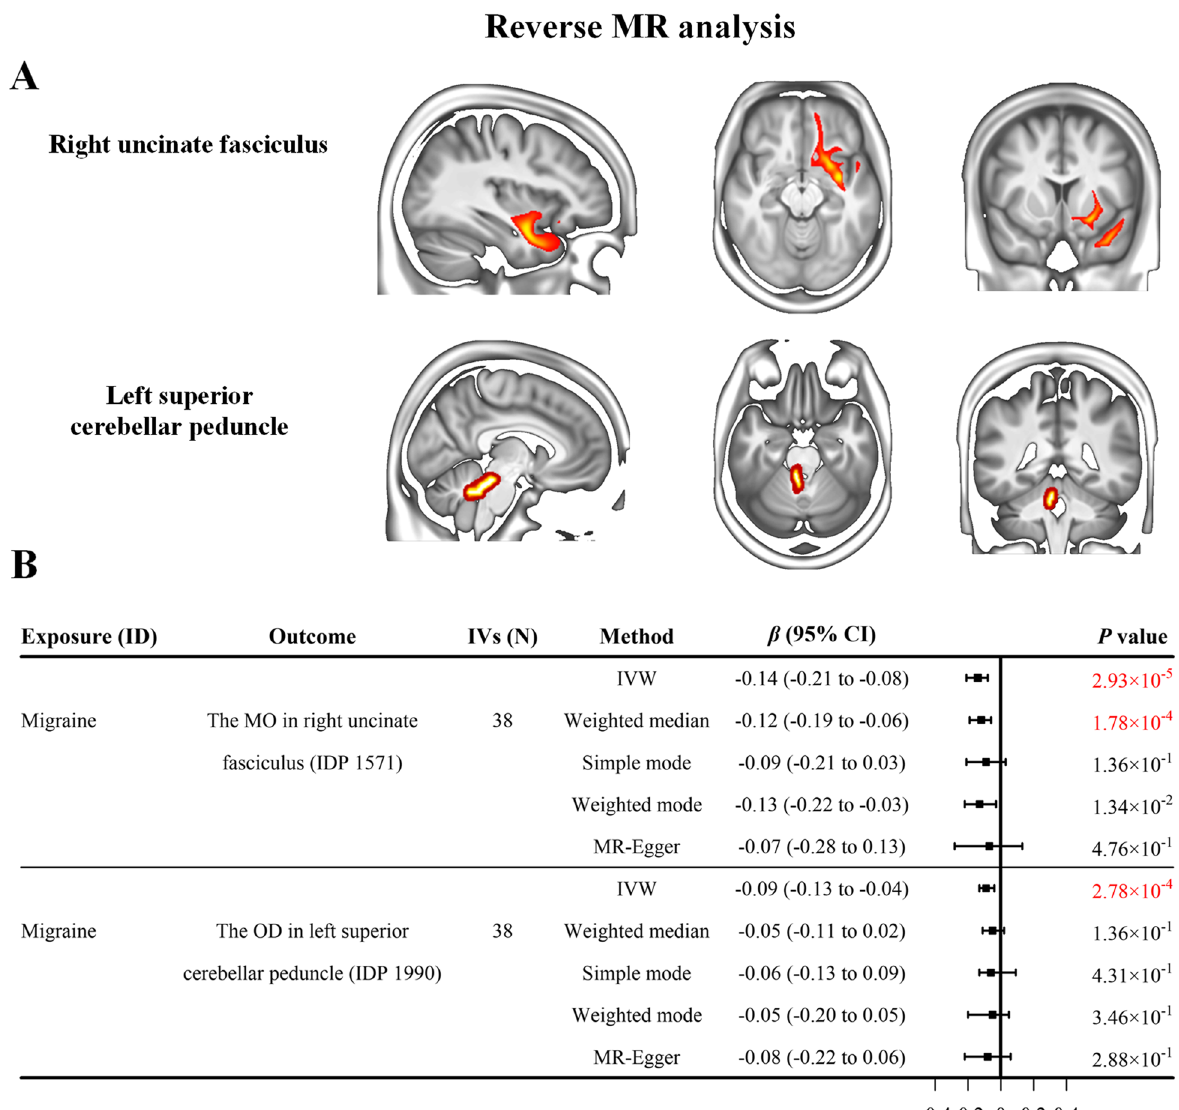
Fig. 3 The results of the reverse MR analysis. A The anatomical locations of the IDPs showing significant causal relationship with migraine in the reverse MR analysis. B The forest plot shows the results of causal estimates. Each box represents the effect (i.e., SD change) of migraine on the respective IDP, and the error bars represent 95% CI. Significant causal correlation is defined as p value < 3.29 and marked by red chroma. The IVW-derived results were regarded as main results. Abbreviations: CI, confidence interval; IDP, imaging-derived phenotypes; IVs, instrumental variables; IVW, inverse variance-weighted; MR, Mendelian